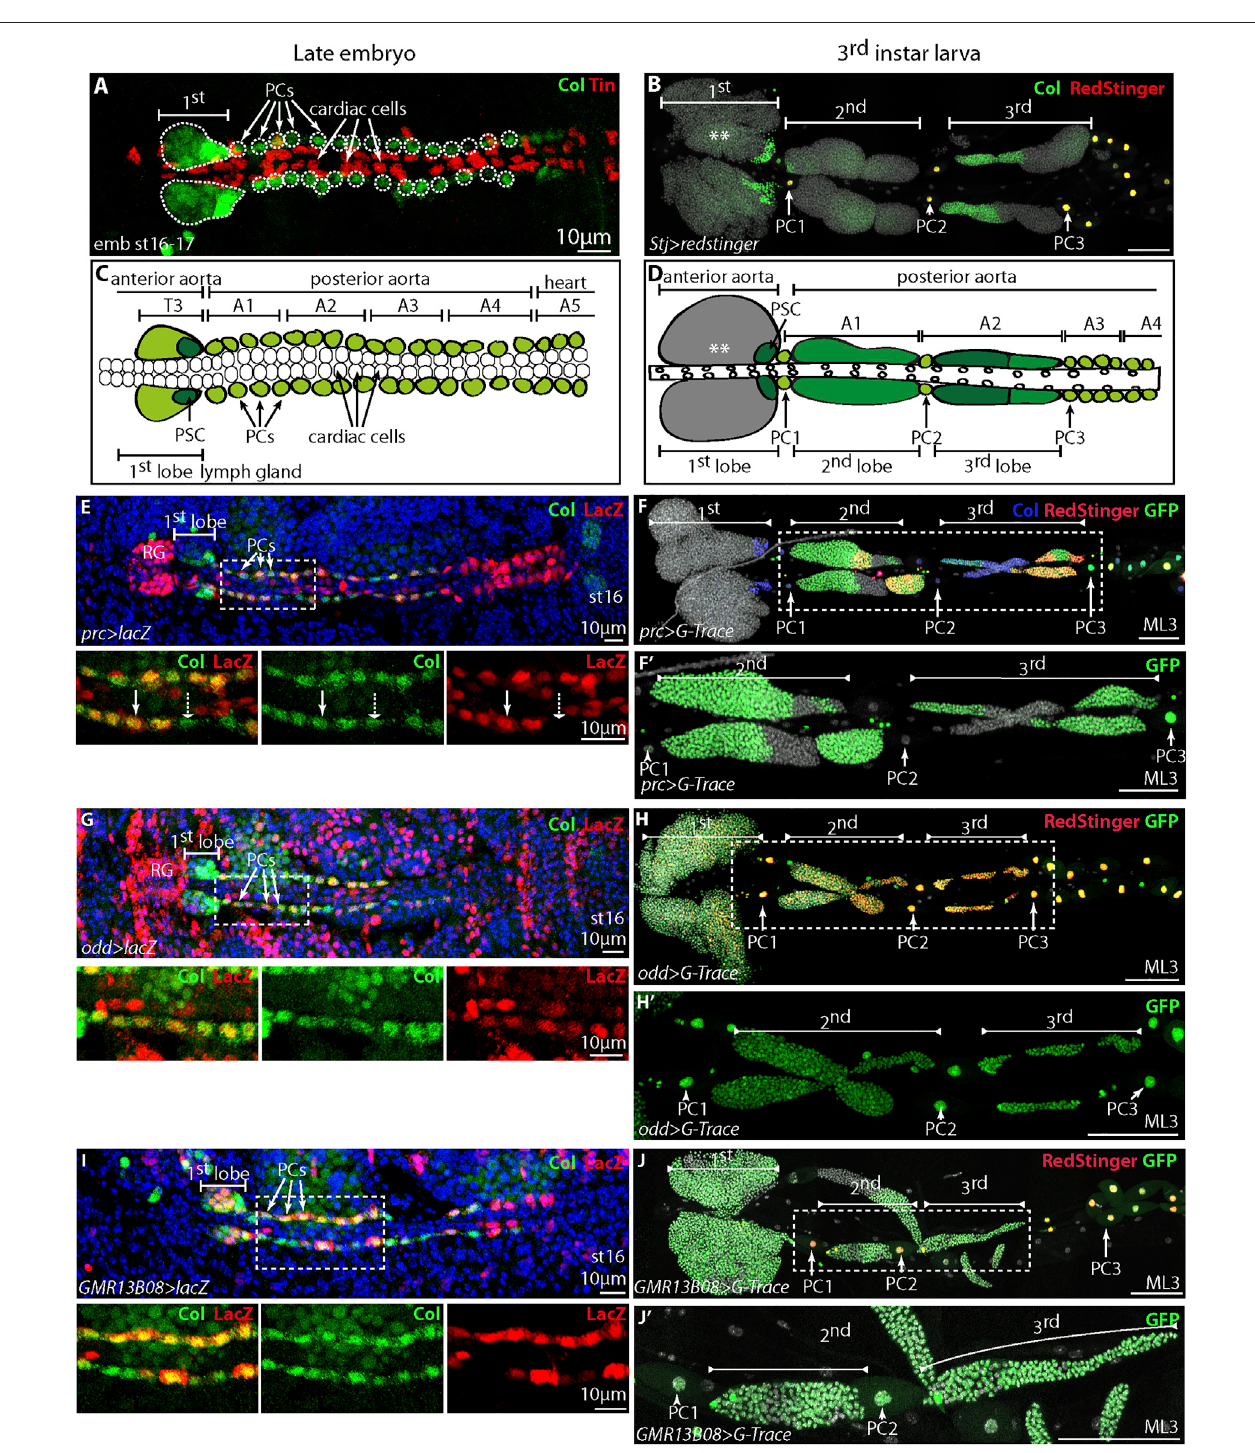
FIGURE1 | Drosophila embryonic and larval cardiovascularsystems. Lymph gland posterior lobes originate from embryonic pericardial cells (A,B) Lymph gland in stage 16 – 17 embryo (A) and third instar larva (B) , Col expression is in green. (A) Col is mainly expressed in the PSC and in a subset of pericardial cells, cardiac cells express Tinman (Tin) (red). (B) Col is expressed in the PSC and progenitors (**) in anterior lobes, in subsets of blood cells in posterior lobes, and in all larval pericardial cells/nephrocytes which express RedStinger under the Straight jacket-Gal4 ( Stj ) driver (red). (C,D) Schematic representation of the cardiovascular system in embryo (C) and L3 larvae (D) . Cardiac cells (white circles) and pericardial cells (PCs) expressing Col in green. Anterior ( fi rst) and posterior lobes (second and third) are indicated. Col expression in green, and dark green when Col expression levels are higher. (E,G,I) Cardiovascular system in stage 16 embryos, Col expression in